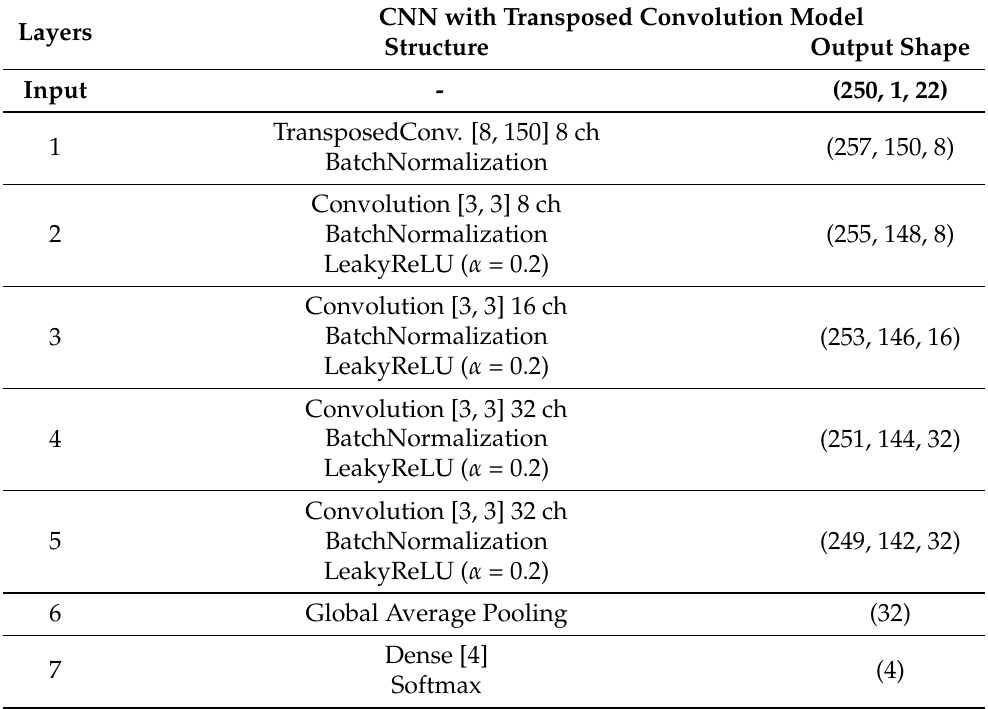
Table 1. The model structure of 2D CNN incorporating a transposed